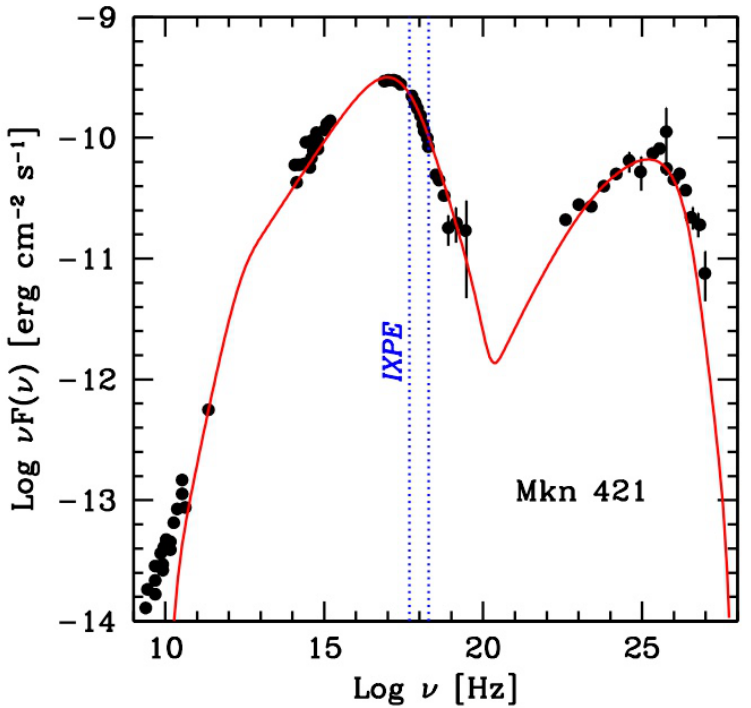
Figure 1. The broadband spectral energy distribution of the prototypical HSP blazar Mkn 421 in a low-medium state (data from [34]). The red line represents the emission calculated with a one-zone synchrotron-self Compton model [32]. Vertical blue dotted lines define the energy range covered by the X-ray polarimeter of the upcoming IXPE satellite, corresponding to the synchrotron emission from the most energetic